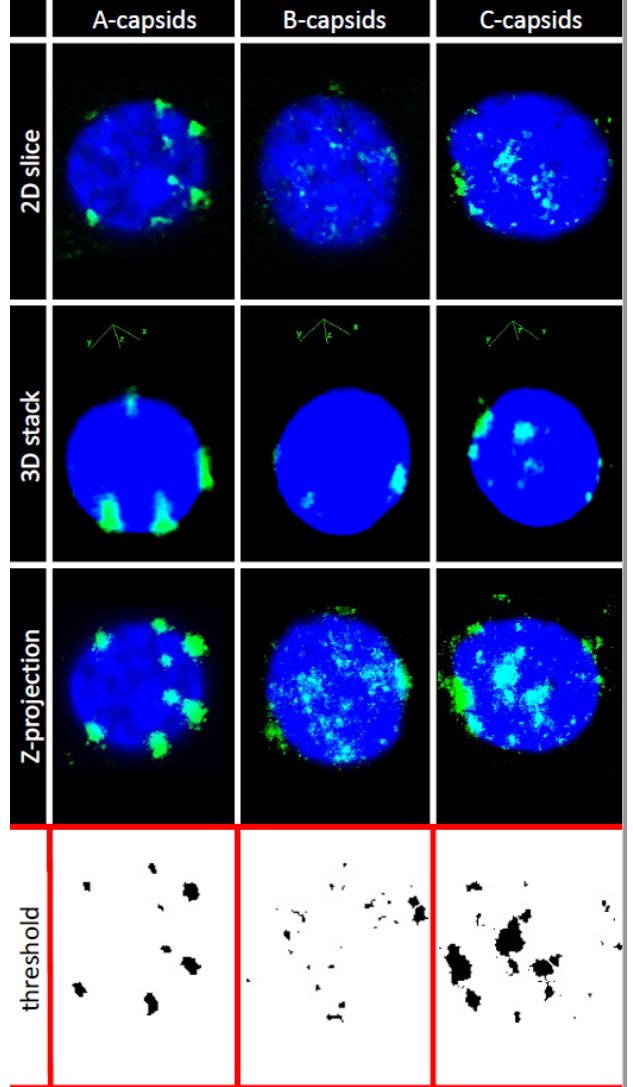
Figure 3. Representative images of reconstituted isolated nuclei with bound A-, B- or C-capsids. The rows show the general procedure (as described in Materials and Methods) to quantify, from a set of stacks, the number of capsids attached to nucleus surface. Steps of confocal fluorescence image anal- ysis are shown for quantification of capsids per isolated cell nucleus. First row is a 2D slice (one focal plane) from the 3D stack GFP capsids (green) on DAPI stained nucleus (blue) in the second row. Third row is a Z-projection in 2D of all confocal plane slices in the 3D stack that was used for quantification of individual capsids, built using non-overlapping green pixels with the highest in- tensity from each slice (corresponding to capsids). Z-projection shows both channels and exhibits the projection of all capsids on a nucleus. The green channel was converted to a binary image using a threshold, as shown in the fourth row, in order to accurately compute number of capsids bound at each nucleus. Capsids outside of the nuclear membrane surface are not counted (as seen in the threshold images). Some nuclei showed capsid aggregates at the surface. Number of capsids in each aggregate was quantified using number of pixels corresponding to an individual capsid applied only to the aggregate surface area immediately at the nuclear membrane, limiting aggregate height to layer thickness corresponding to one capsid diameter. Automated capsid counting using these